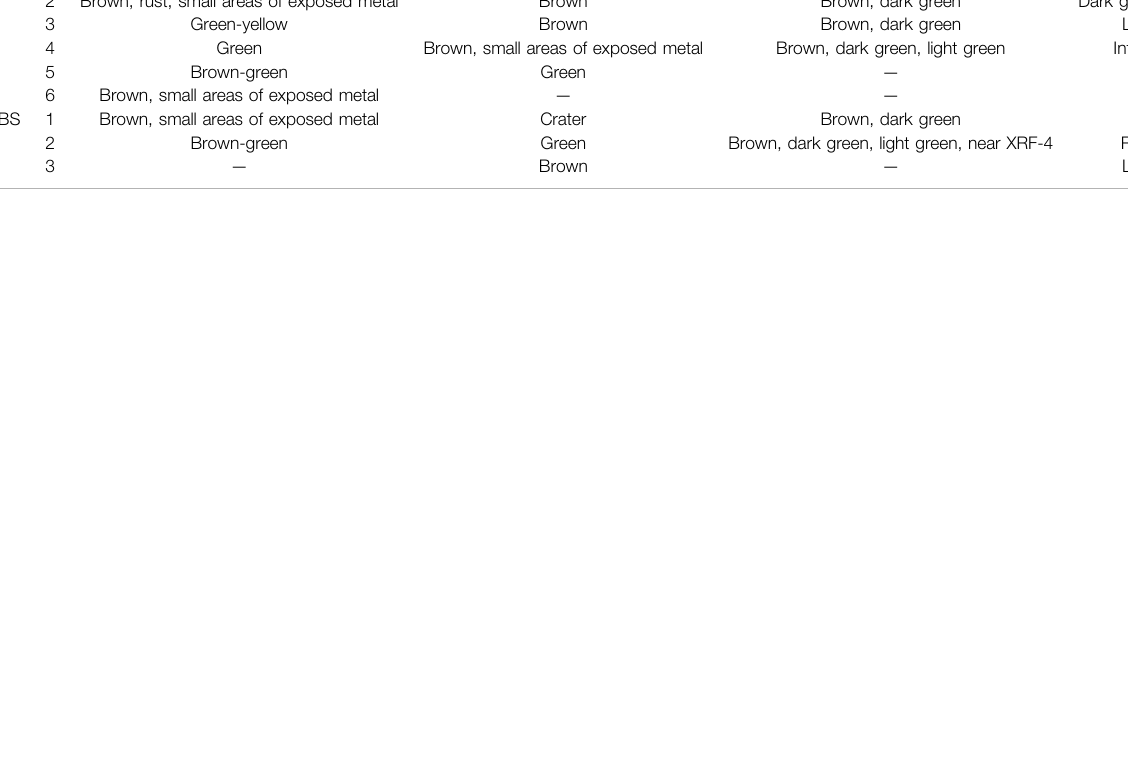
TABLE 3 | Short description of the analysis areas. 2941 2952 XRF Brown, rust, small areas of exposed metal